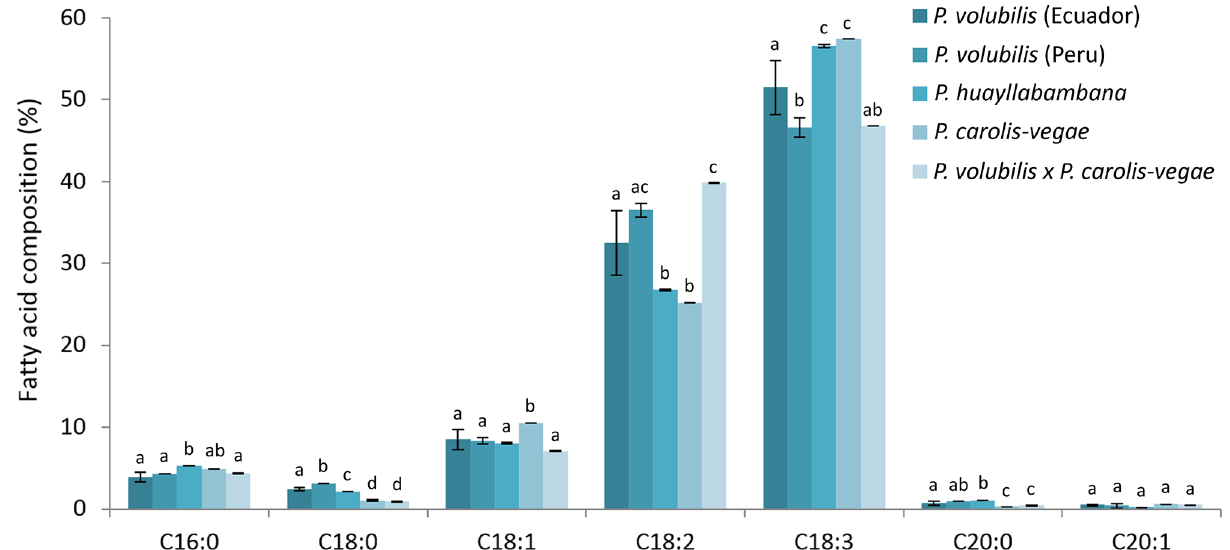
Figure 2. Composition of the lipid fraction of different Plukenetia species and cultivars, n = 3 (except P. volubilis × P. carolis-vegae , n = 2). C16:0, palmitic acid; C18:0, stearic acid; C18:1, oleic acid; C18:2, linoleic acid; C18:3, linolenic acid; C20:0, eicosanoic acid; C20:1, eicosenoic acid. Letters indicate significant